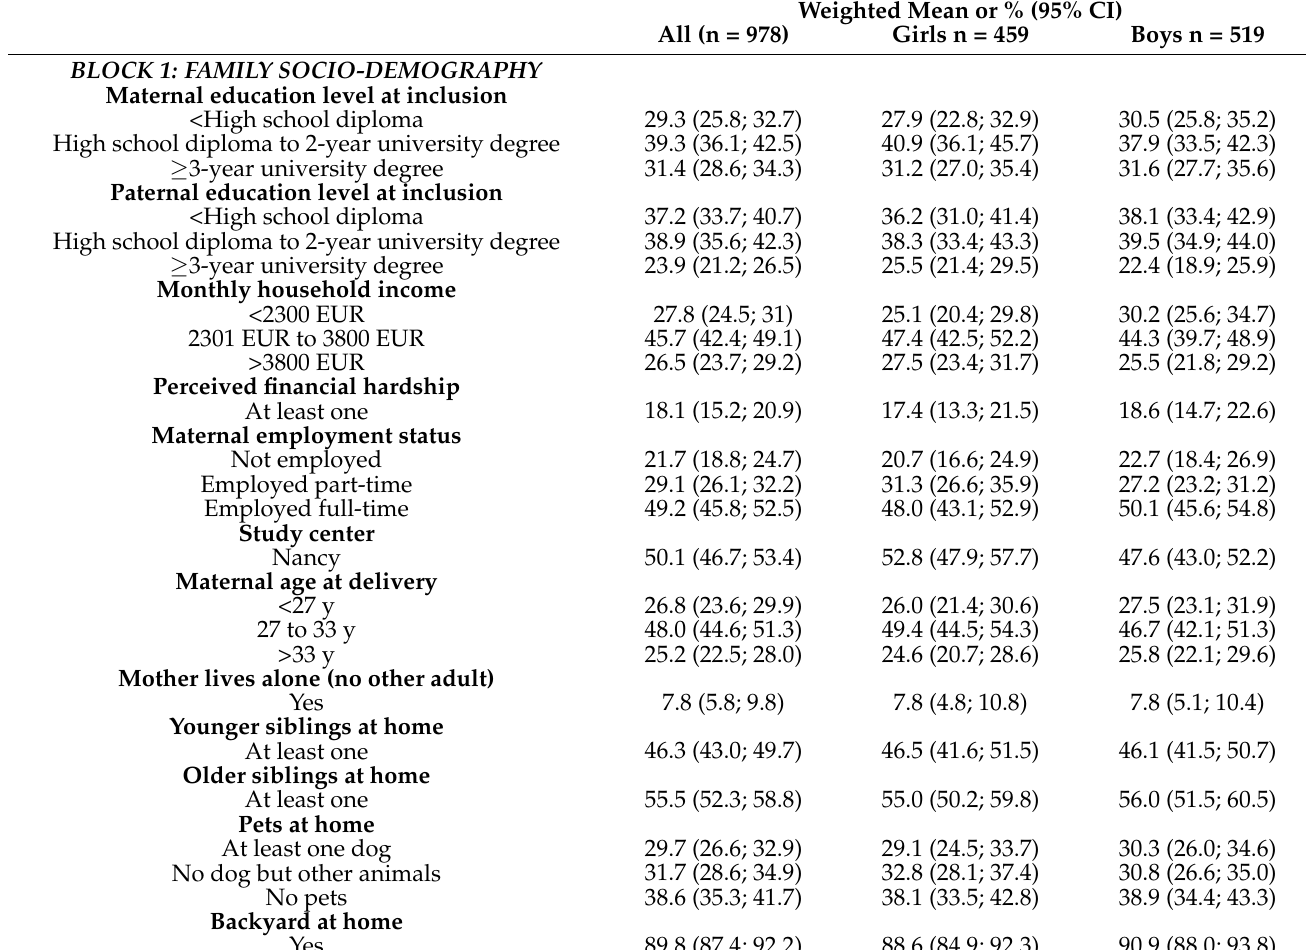
Table 1. Population characteristics at year 5, according to the child’s sex. The EDEN study. Weighted Mean or % (95% CI) All (n = 978) Girls n = 459 Boys n = 519 BLOCK 1: FAMILY SOCIO-DEMOGRAPHY Maternal education level at